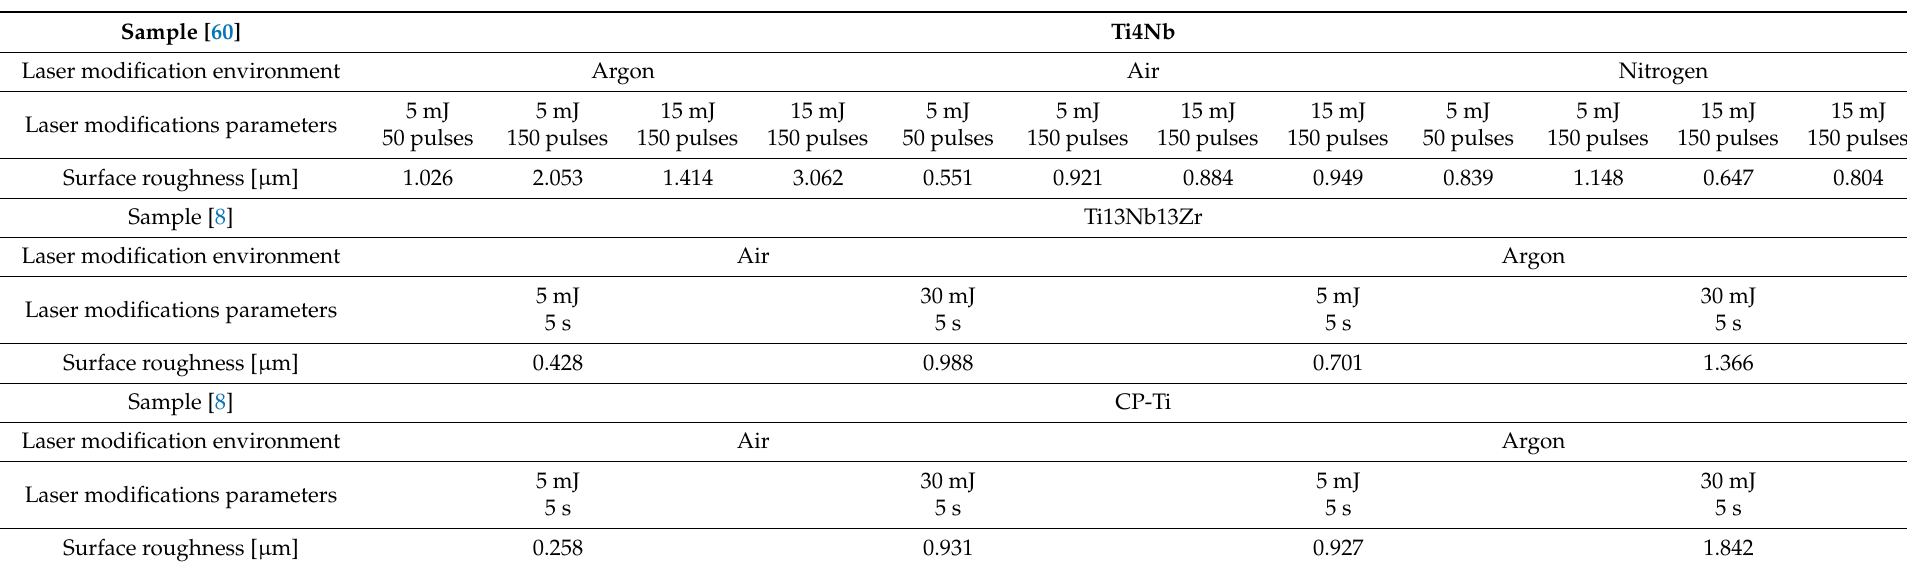
Table 2. Surface roughness depended on the laser modification environment